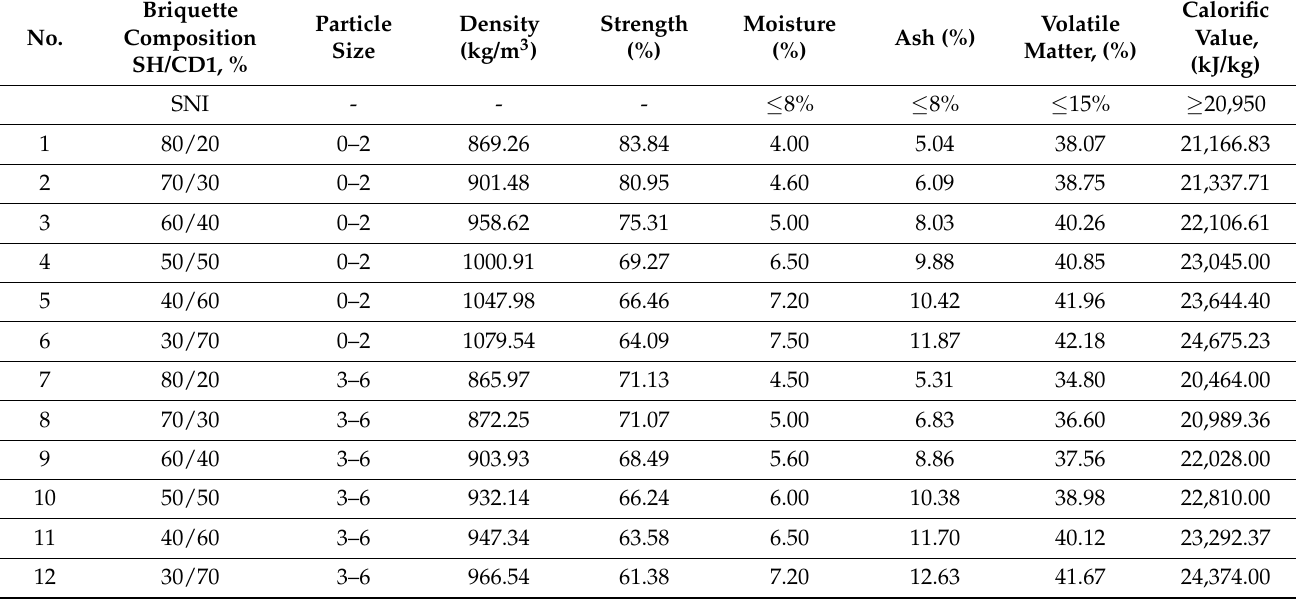
Table 2. The results of the analysis of briquettes (sunflower husk and Karazhyra coal